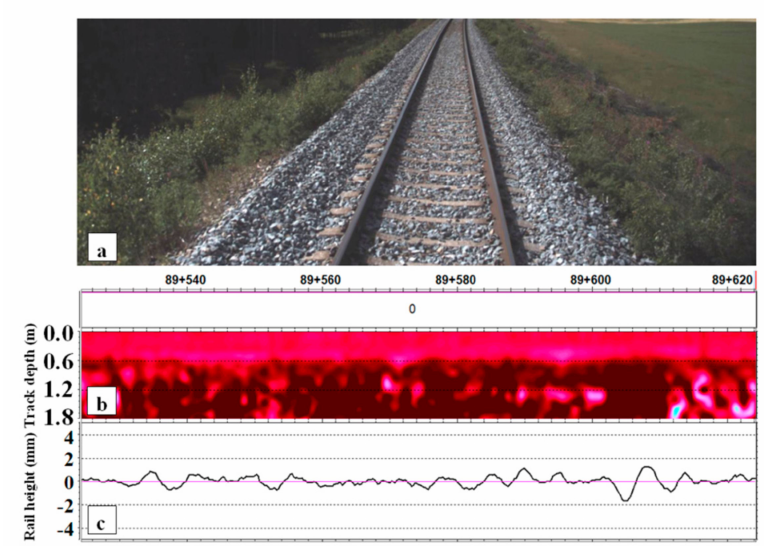
Figure 6. Measurement results of open track: ( a ) photograph of the track; ( b ) the moisture profile; and, ( c ) the longitudinal track